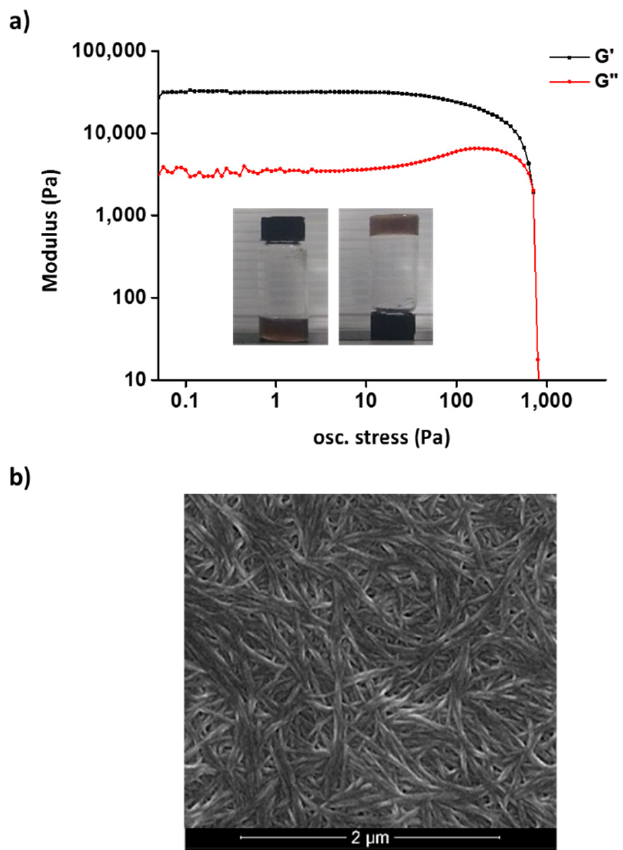
Figure 2. ( a ) Stress sweep rheometry (storage/elastic moduli G ′ in black and viscous moduli G ′′ in red) and inversion tube test images for L1 in DMSO/H 2 O (H 2 O 15% v / v ) (2.0% w / v ); ( b ) SEM image of the xerogel of L1 showing the stiff network of fibres. Oscillatory amplitude sweeps at a constant frequency (1 Hz).